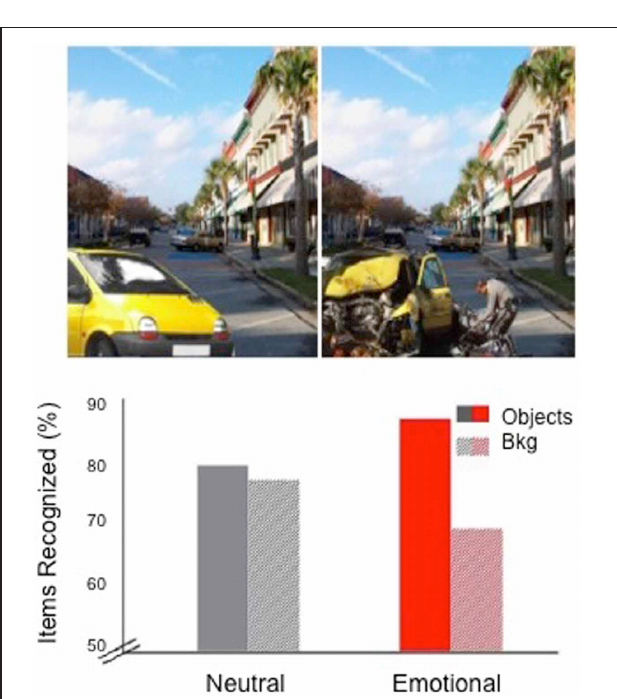
FIGURE 2 | The emotional memory trade-off effect. Top —Sample stimuli with the identical neutral backgrounds and either a neutral (left) or negative emotional (right) object in the foreground; Bottom —Emotional trade-off (following a 30min delay, from Payne et al., 2008) is seen on right as increased recognition of emotional objects with impaired recognition of neutral backgrounds. Figure adapted from Payne and Kensinger